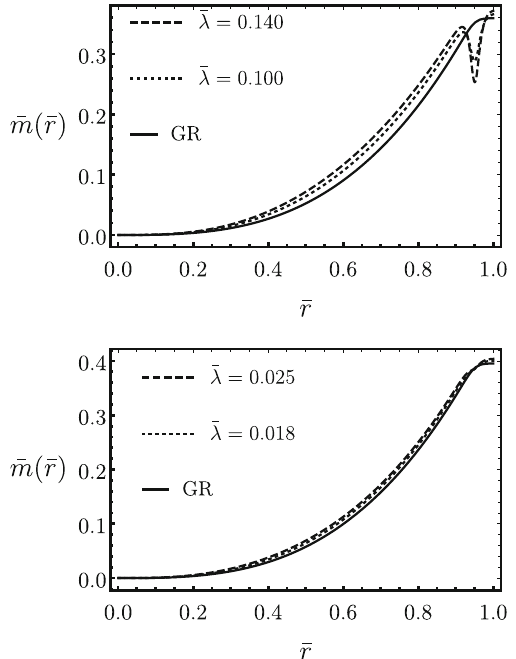
Fig. 9 ¯ m as a function of ¯ r , for ¯ ρ 0 = 0 . 100 (upper panel), and ¯ ρ 0 = 0 . 110 (lower panel)